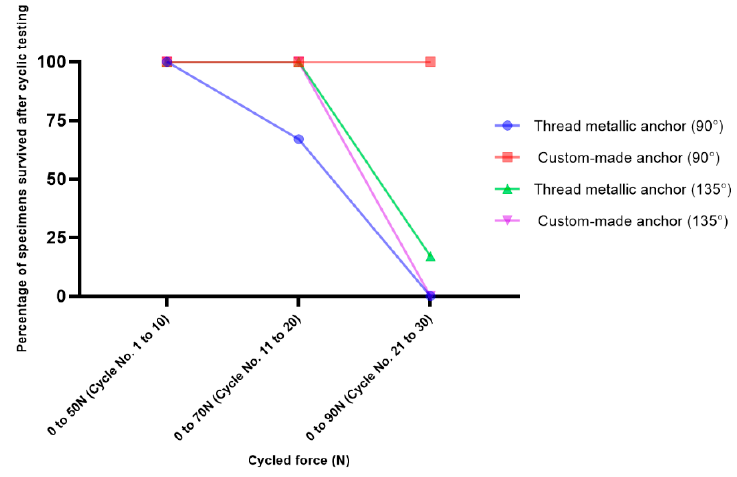
Figure 5. Compared to different insertion angle, cycled force and cycle numbers of survival propor- tions.